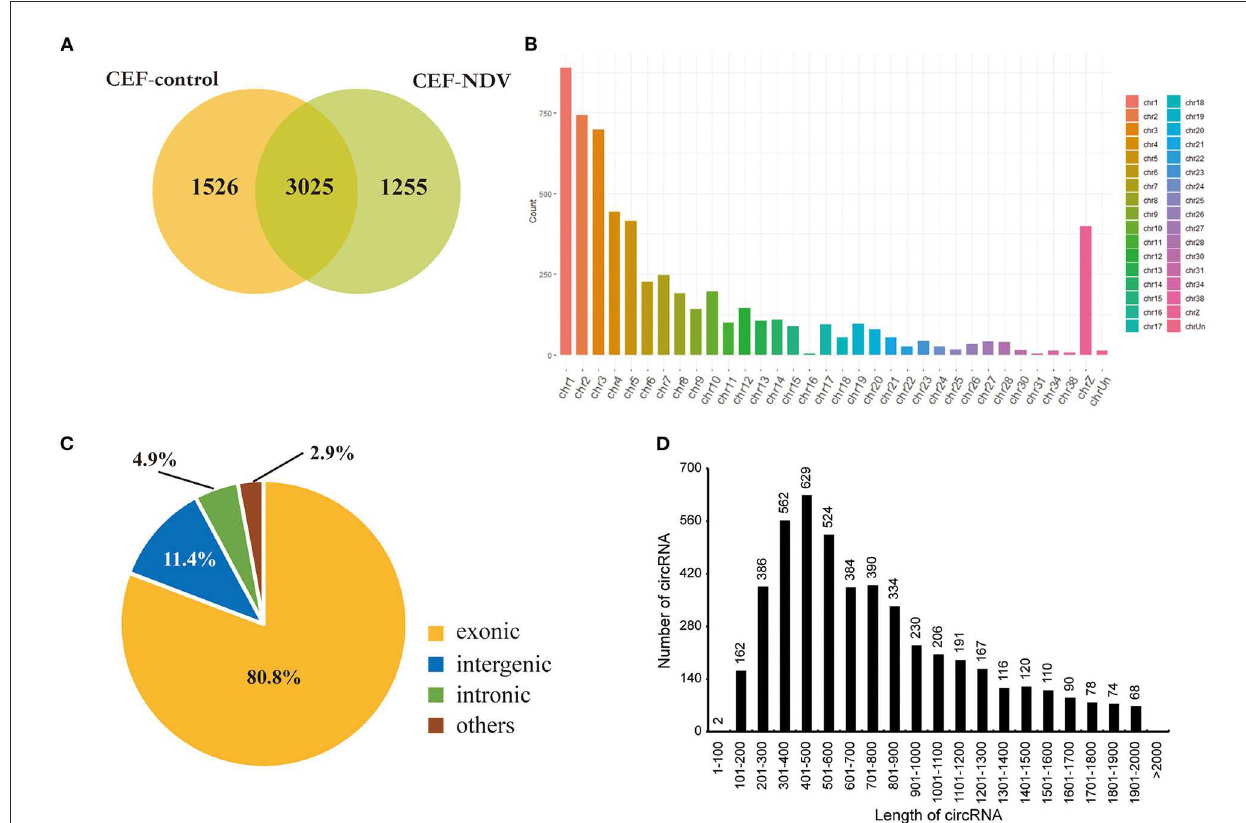
FIGURE1 CircRNA expression profile in CEFs. (A) circRNAs expressed in CEFs with or without NDV infection. Using find_circ performs circular RNA identification on sequencing results. (B) circRNAs expressed on each chromosome in CEFs. (C) Different circRNAs expressed in CEFs. (D) Length of circRNAs expressed in CEFs.